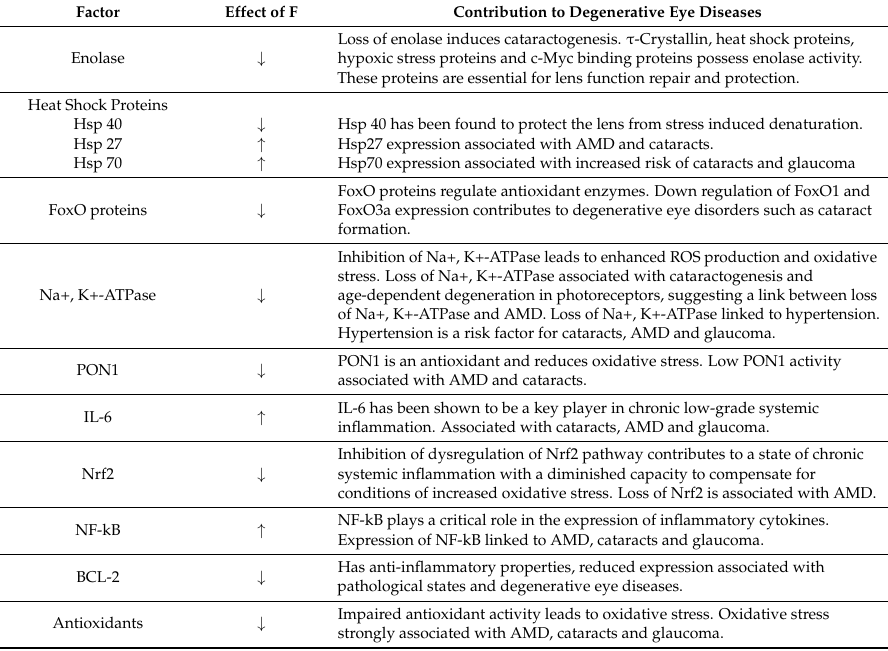
Table 1 summarises key molecular pathways by which F contributes to eye diseases. Hsp: Heat shock protein; FoxO: Foxhead box ‘Other’ proteins; PON1: Paraoxonase 1; N2f2: Nuclear factor erythroid-2-related factor 2 Nuclear factor; IL6: Interleukin 6; NF-Kb: Nuclear Factor kappa-light-chain-enhancer of activated B cells; BCL-2: B-cell lymphoma